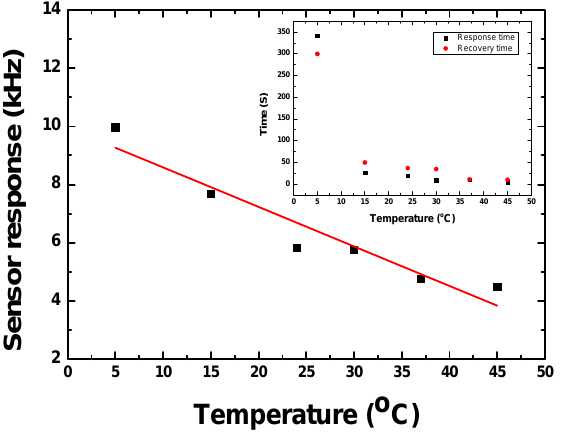
Figure 9. The temperature effect on sensor response and on response and recovery